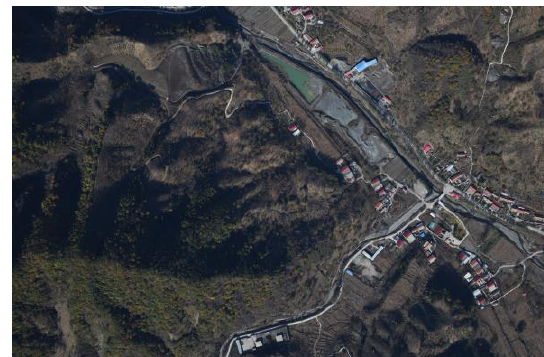
Figure 5. One of the aerial images of surveying area B